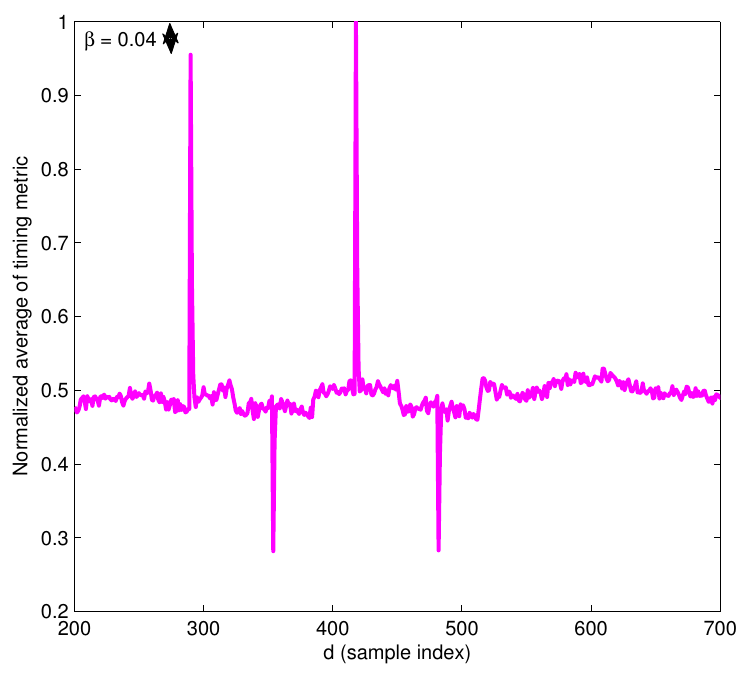
Figure 3. Plot of normalized average of the modified Park’s timing metric (6) for an ACO-OFDM system with N = 256, U = 5, cp = N /8, SNR = 10 dB, and